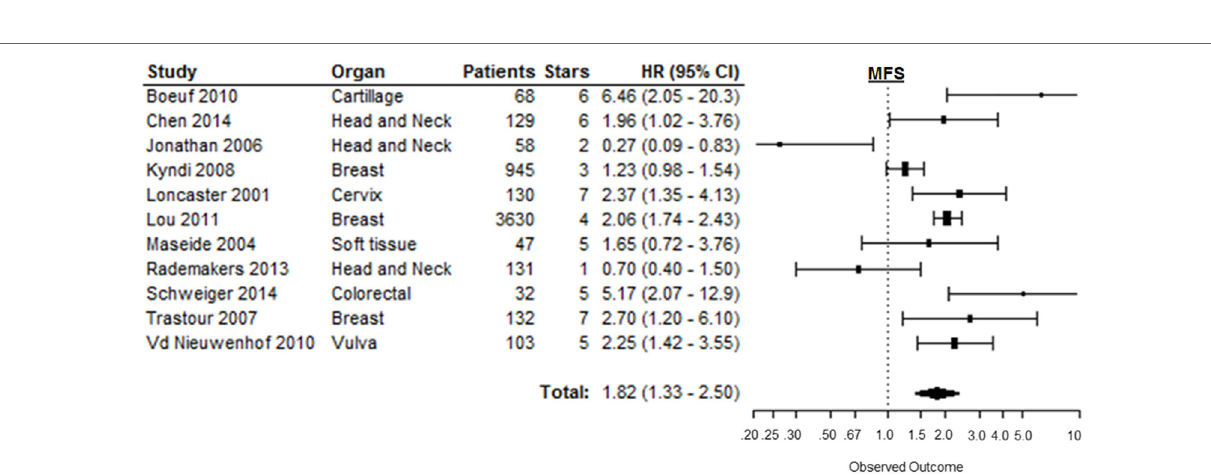
FiGURe 7 | Forest plot of the papers describing the association between CAiX expression and MFS . Horizontal bars represent HR with corresponding 95%CI. Symbol size represents the assigned weight of the study. The overall HR with 95%CI is visualized with the diamond shape. Dashed line indicates no association between CAIX and prognosis (24, 27, 34, 52, 95, 102, 140, 34, 150, 165, 167,